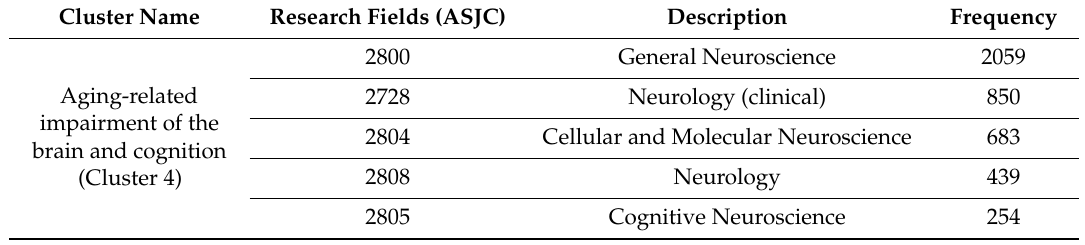
Table 5. Major research fields in Aging-related impairment of the brain and cognition (Cluster 4).